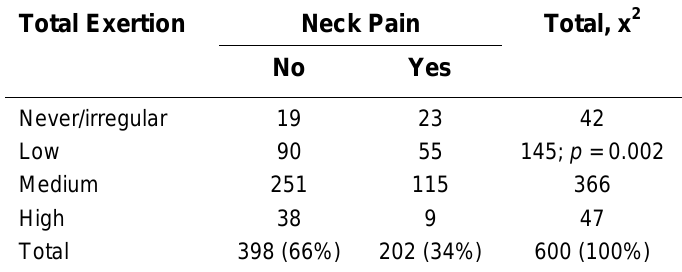
Level of Exertion by Students that Reported Neck Pain During the Last 3 Months (n = 600, 8 People